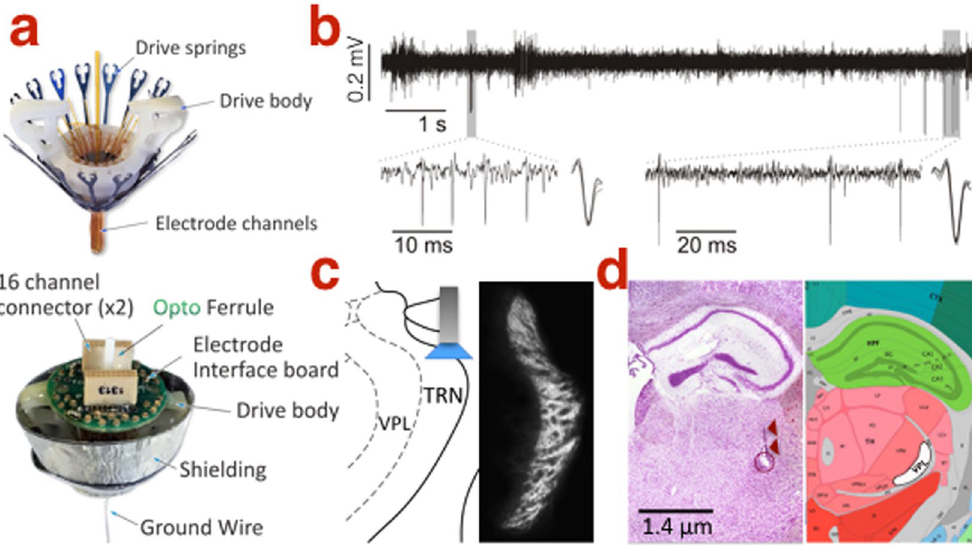
Figure 1. Extracellular in vivo recording. ( a ) Assembly of the FlexDrive stereotrode system mounted with a fiberoptic ferrule. ( b ) Isolation of two putative single-units from a 300–3000 Hz band-pass local field potential. ( c ) Channelrhodopsin-2 expression restricted to TRN in the VGAT mouse. ( d ) Representative coronal section showing electrolytic lesion (circle; arrows mark tetrode track) denoting a recording site in VPL (white shadow in right panel; Photo in 1d is adapted from the Allen Developing Mouse Brain Atlas; for reference see h tt p: // at- la s. br ai n- ma p. or g/ atlas?atlas = 1&plate = 100960228#atlas = 1&plate = 100960228&resolution = 18.60&x = 5535.99 9348958333&y = 4142.9498693678115&zoom =− 4, and for copyright policy see https://www.alleninstitute.org/ legal/citation-policy/).